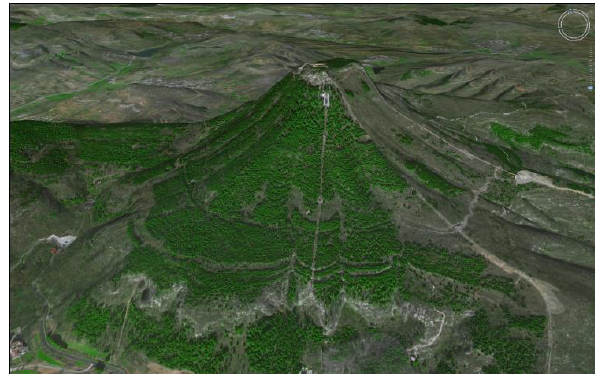
Figure 4. The DaiGu landform: Baodu Gu